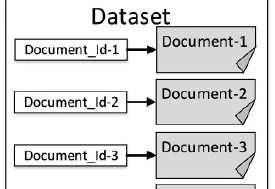
Figure 1 . Document Store Database (Grolinger et al., 2013)